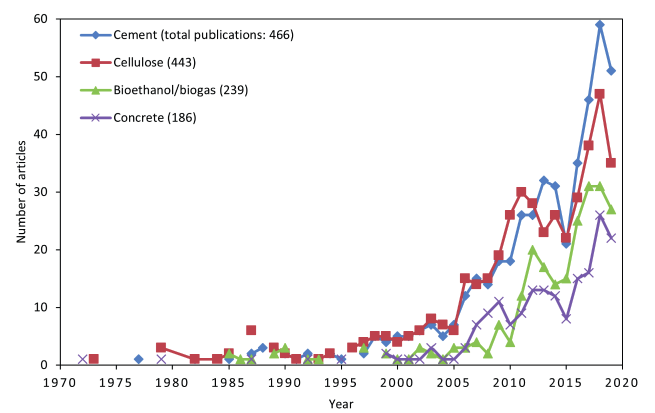
Fig. 6. Research trends of the selected major applications in paper